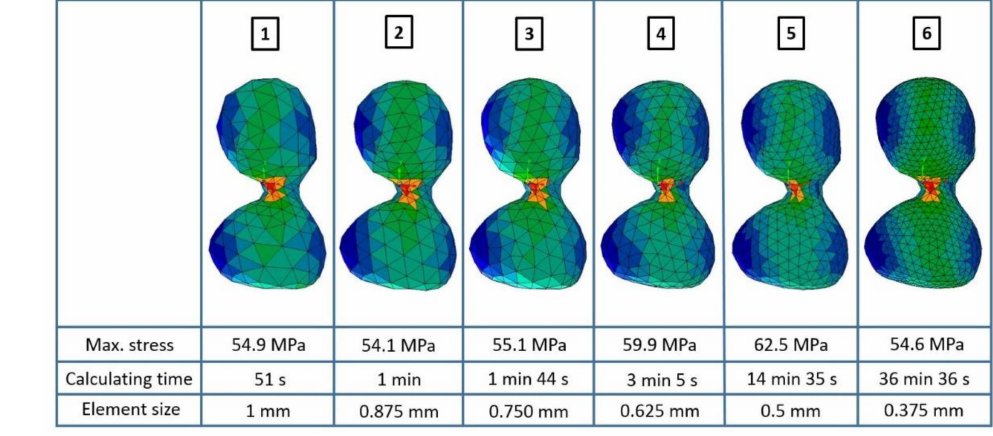
Figure 12. Mesh sensitivity